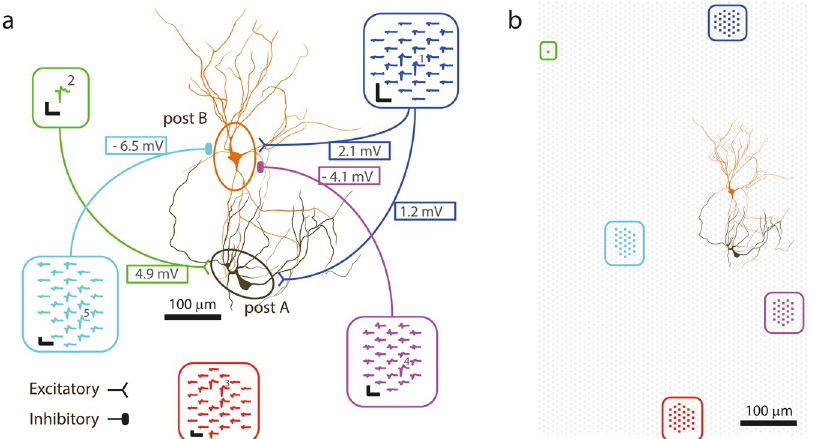
Figure 5. Connectivity diagram for the synaptic inputs mapped in Fig. 4. ( a ) Synaptic connections of the neurons in Fig. 4 and their average PSP amplitudes. Extracellular footprints of the presynaptic (inside rounded rectangles) and morphology of two postsynaptic neurons (in ellipses). The footprints were extracted from spontaneous activity recordings in the incubator prior to the experiment. The green neuron did not fire APs during the spontaneous scan, therefore its multi-electrode footprint could not be identified. Numbered electrodes correspond to the trace numbering in Fig. 4, scale bars of blue and violet footprint: 200 µ V/3 ms; of other footprints: 400 µ V/3 ms. ( b ) Locations of HD-MEA electrodes (gray background dots), electrodes used to record the footprints (colored dots) and patch-clamped neurons on the